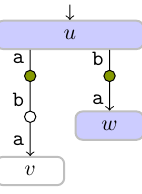
Figure 9. Excerpt of the suffix tree depicting three edge witnesses. Implicit trie node are represented by small rounded nodes ( ), which are shaded if they are LZ trie nodes ( ). The explicit LZ trie nodes u and w are shaded in blue ( ). According to the figure, n v = 1 and n w = 2. In particular, the exploration counters of u and w are